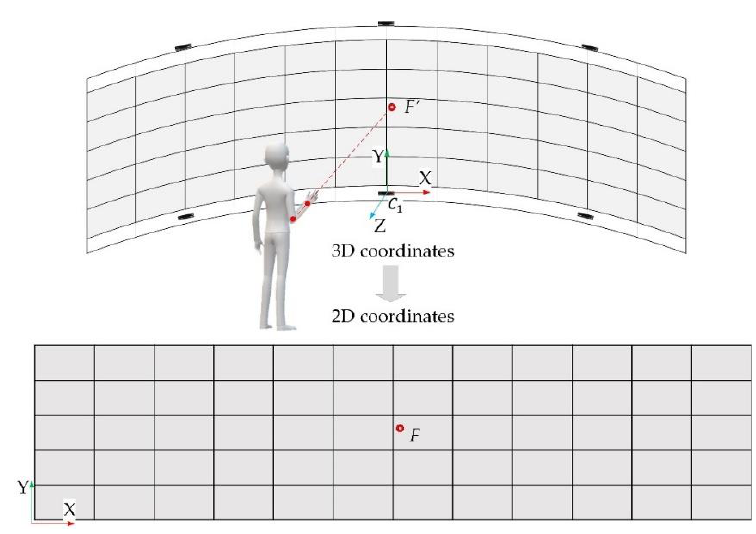
Figure 5. Calculate